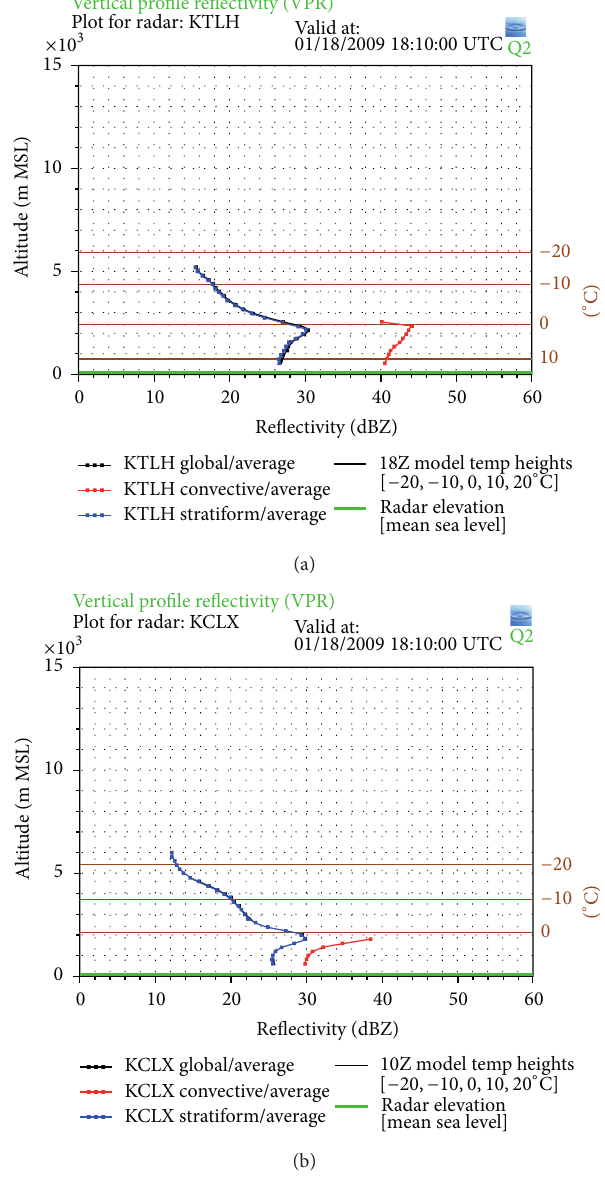
Figure 9: Vertical profiles of reflectivity from (a) Tallahassee, FL, and (b) Charleston, SC. The dark line shows the reflectivity values for stratiform precipitation, where the peak shows the